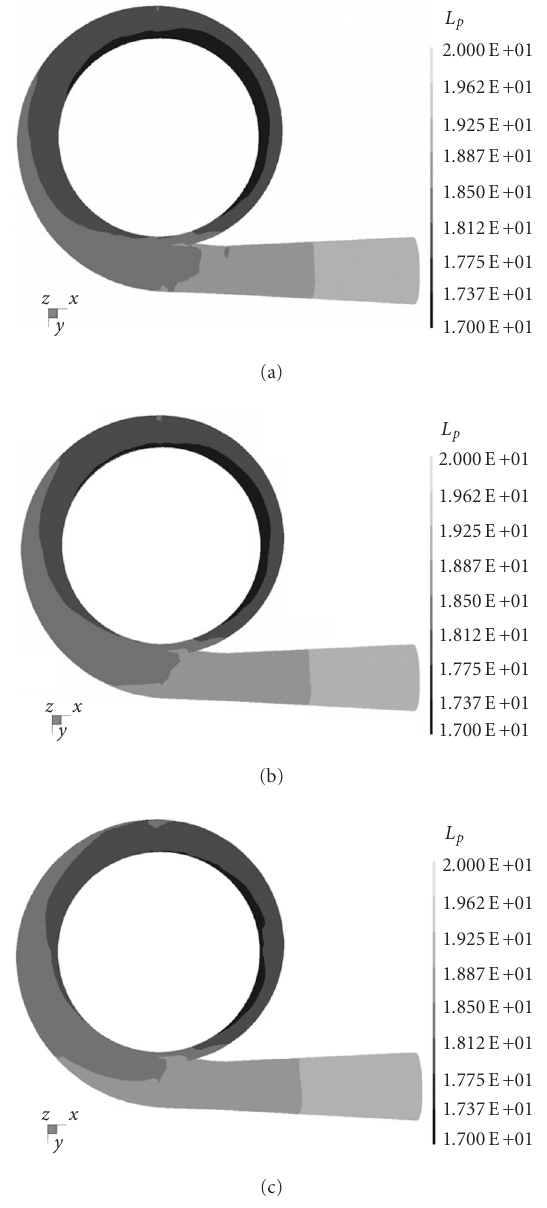
Figure 20: Static pressure on the volute surface for the vaned case at design conditions: (a) starting position, (b) 1 / 3 revolution, and (c) 2 / 3